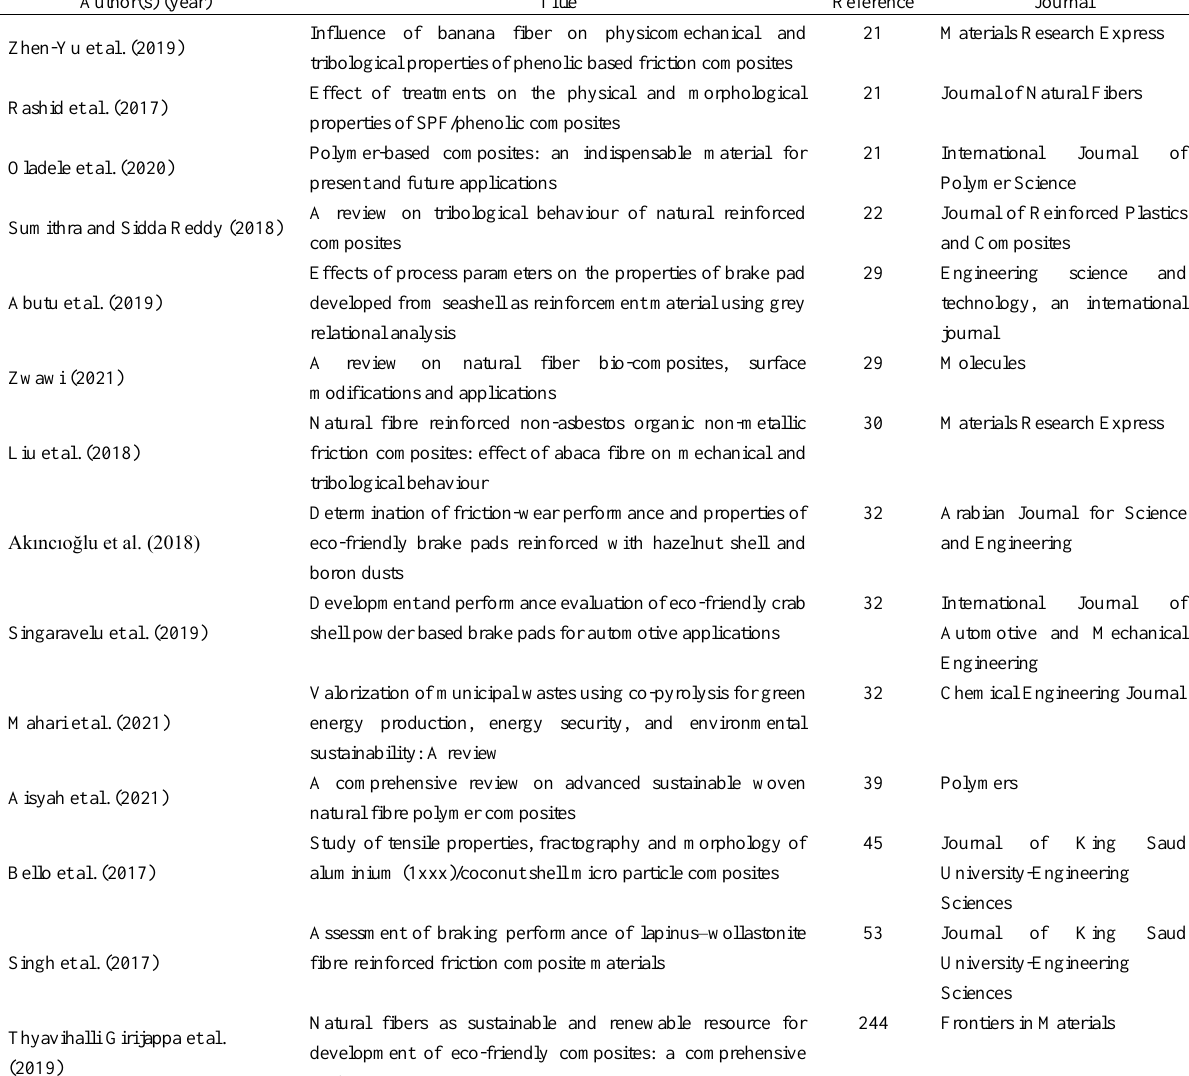
Table 2. Publication data on brake pad study from the 14 articles cited the most in the 2017-2021 period Author(s)